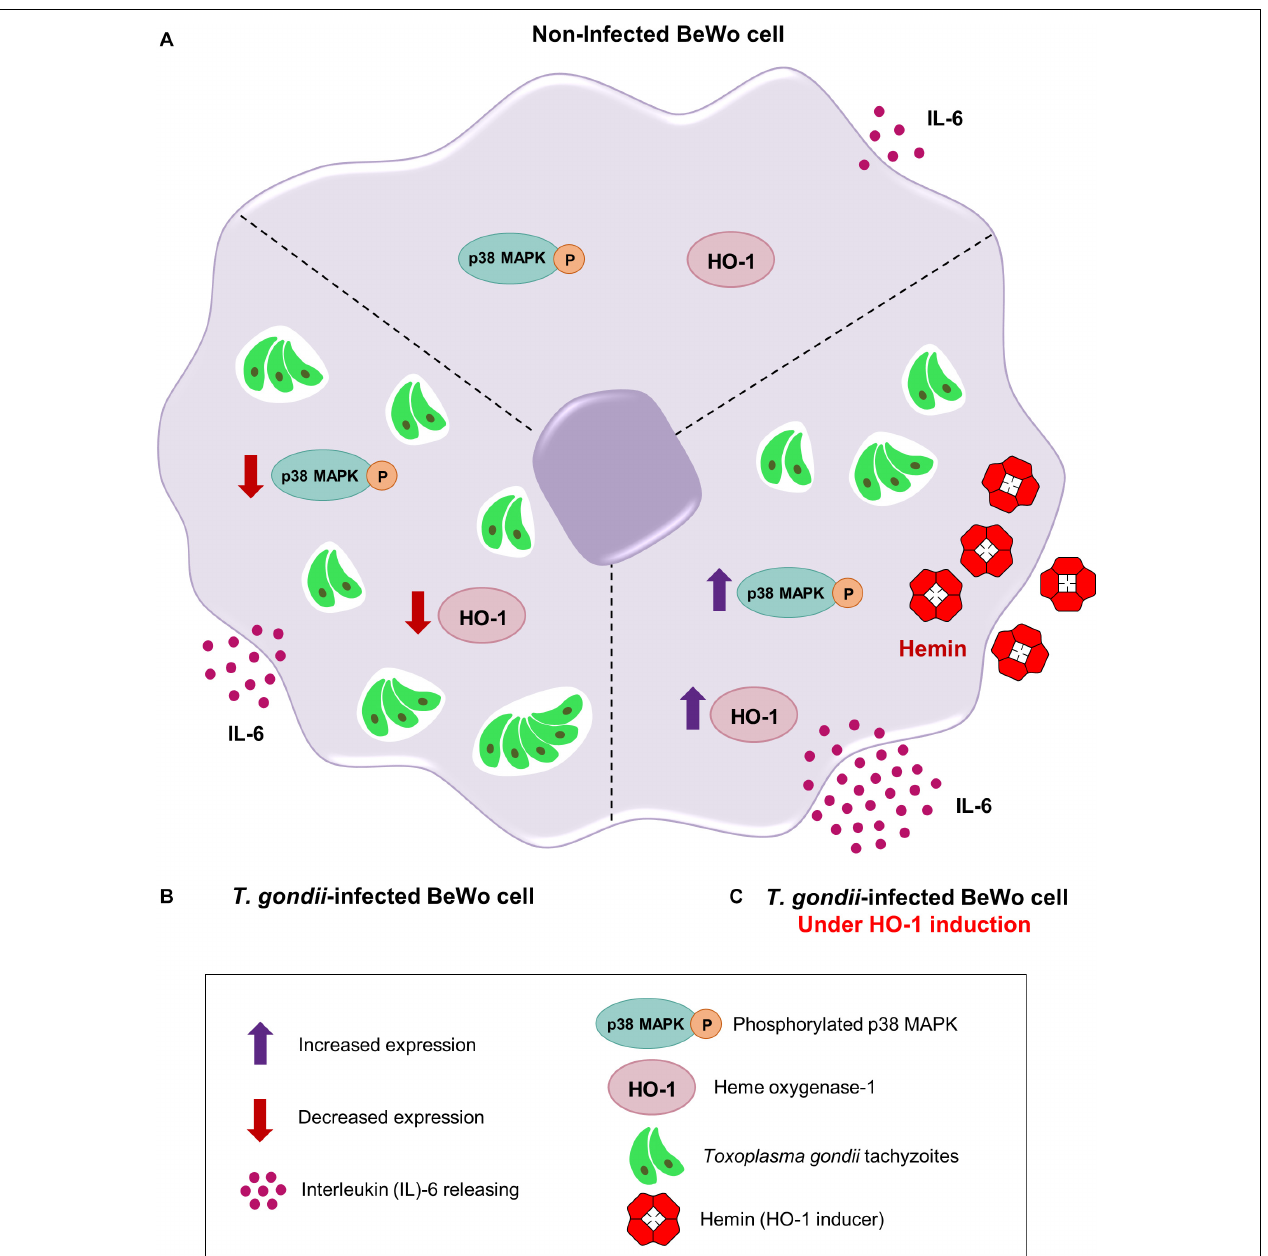
FIGURE 6 | Proposed mechanisms triggered by the HO-1 to control T. gondii infection by BeWo trophoblast cells. (A) Upper panel, a non-infected BeWo cell expresses normal levels of HO-1 and phosphorylated p38 MAPK, in addition to secreting baseline levels of IL-6. (B) Left panel, when BeWo cells were infected with T. gondii , the amounts of HO-1 and phosphorylated p38 MAPK were significantly decreased and the IL-6 levels were upregulated. (C) Right panel, when finally T. gondii -infected BeWo cells were treated with hemin, a specific HO-1 inducer, the parasite proliferation was significantly reduced, sequentially associated with an overexpression of HO-1, an increasing of the p38 MAPK phosphorylation and a releasing of high IL-6 levels, which was higher than those naturally secreted by the T. gondii -infected cells non-induced for HO-1 (left